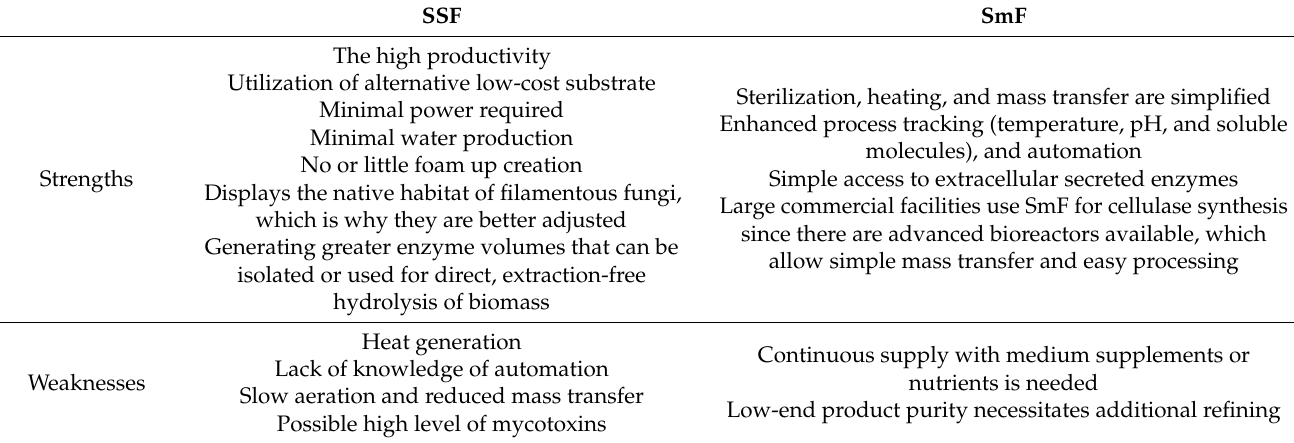
Table 2. Strengths and weaknesses of SSF and SmF during cellulase production by